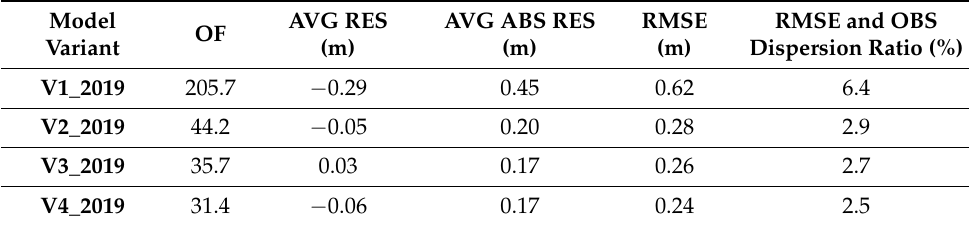
Table 3. Prediction characteristics of individual model